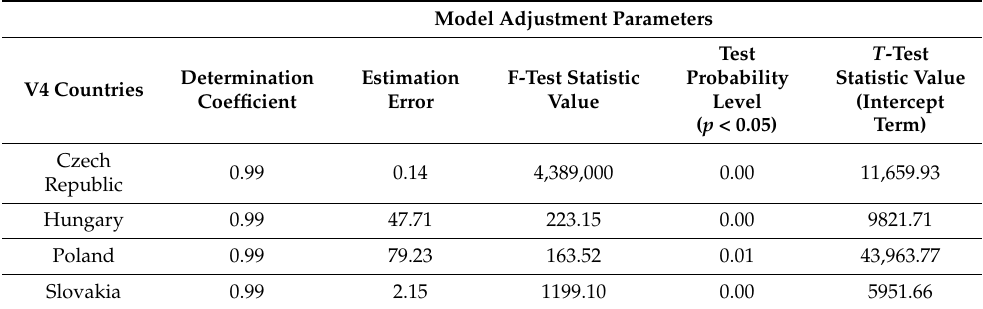
Table 2. Evaluation results of the significance of the parameters of a multiple linear regression model. Model Adjustment Parameters V4